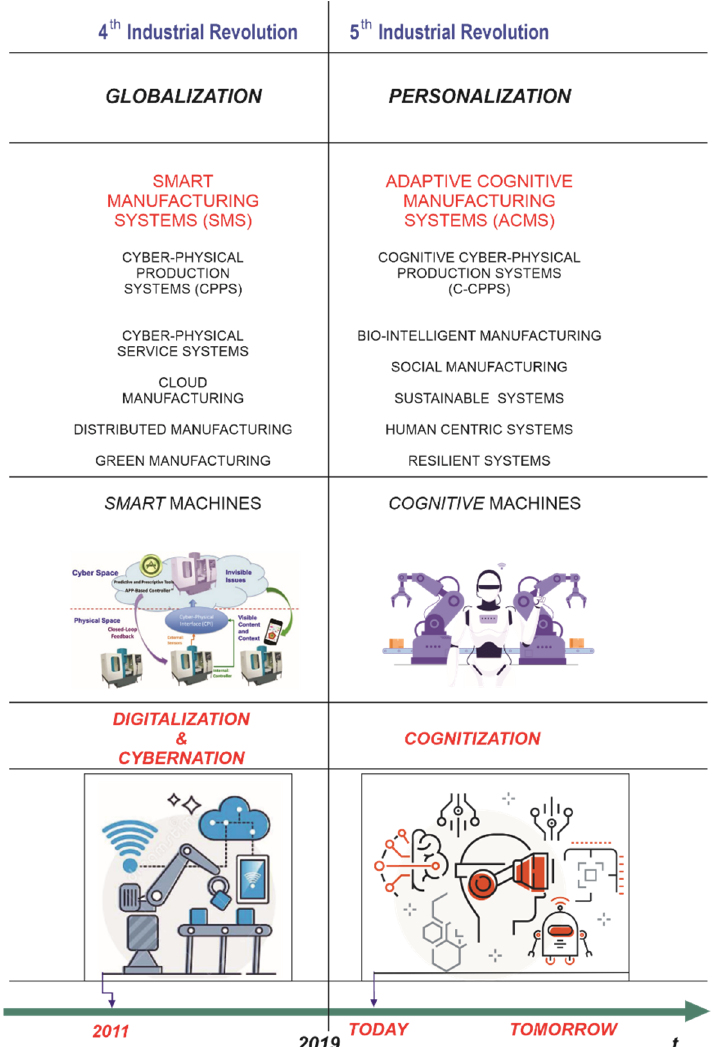
Figure 14. Evolution from Industry 4.0 to Industry 5.0.